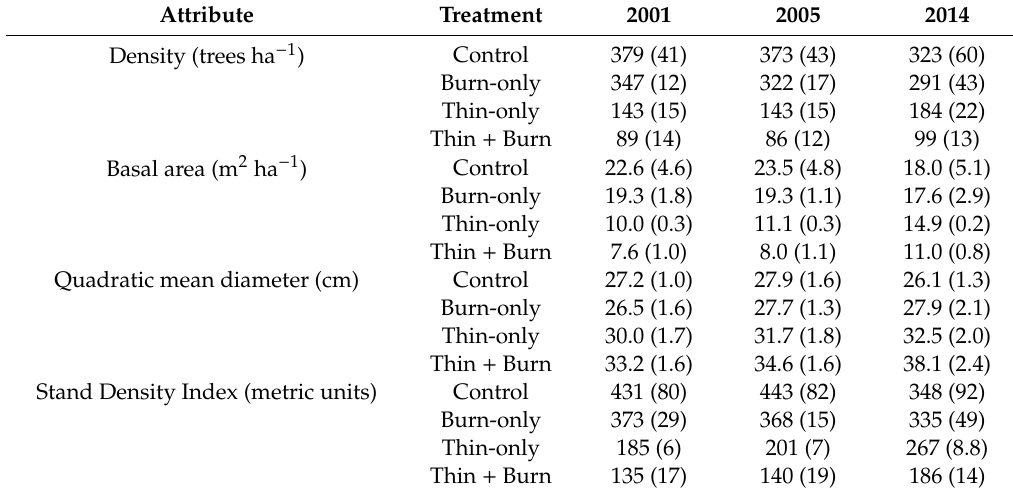
Table 1. Stand summary statistics for Lubrecht’s Fire and Fire Surrogate Study across measurement years. Data presented are aggregated means of experimental units and 1 standard error. Note that the 2001 date is post-harvest but pre-burn, and that insect outbreak occurred between the 2005 and 2014 measurements. We considered 1111 the maximum Stand Density Index [38] in these ponderosa pine stands, per [39].